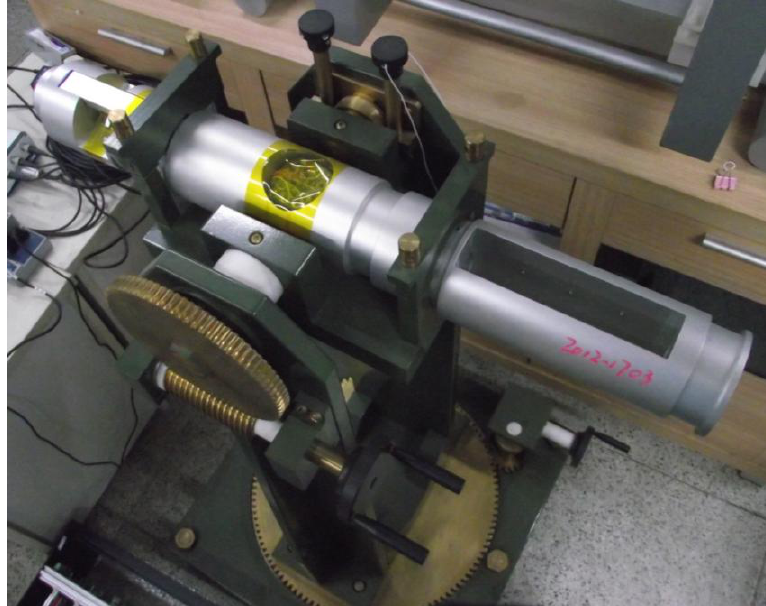
Figure 6. Nonmagnetic